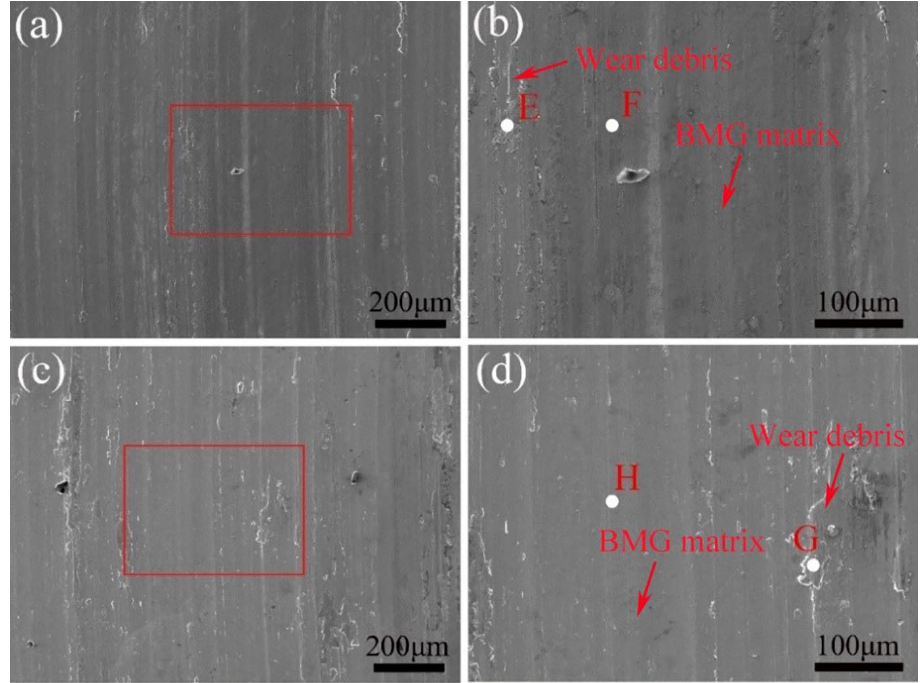
Figure 7. ( a , c ) SEM images of worn scars of as-cast and treated BMGs tested in 3.5% NaCl solution, respectively. ( b , d ) High-magnification detailed micrographs corresponding to the part marked by the red-lined rectangular in ( a , c ), respectively.